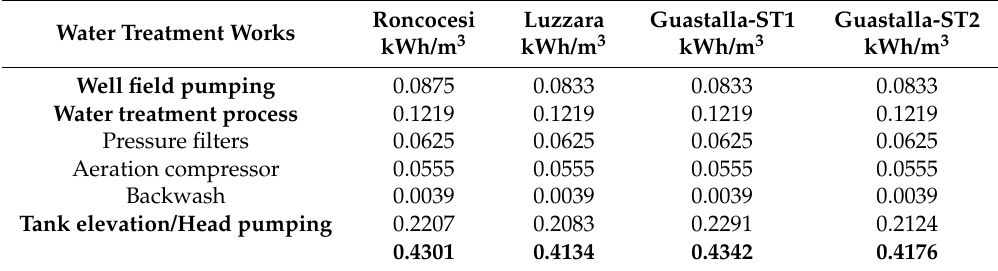
Table 8. Energy contribution for water treatment plants for BAU and alternative strategies.